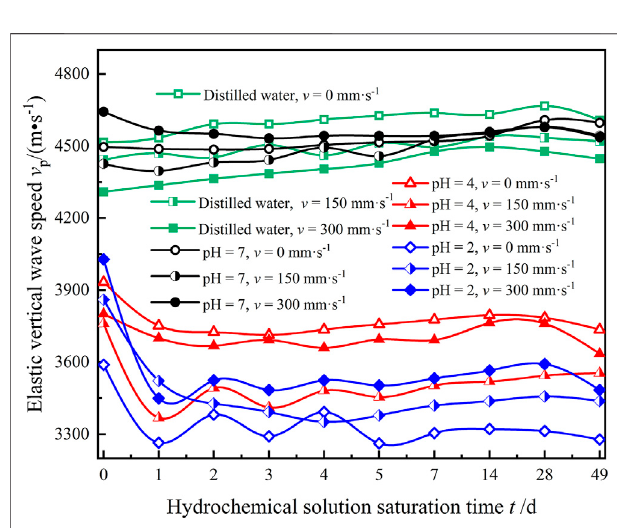
FIGURE8| Time-dependentcurveoftheaqueouschemicalsolutionpH value in the test process.